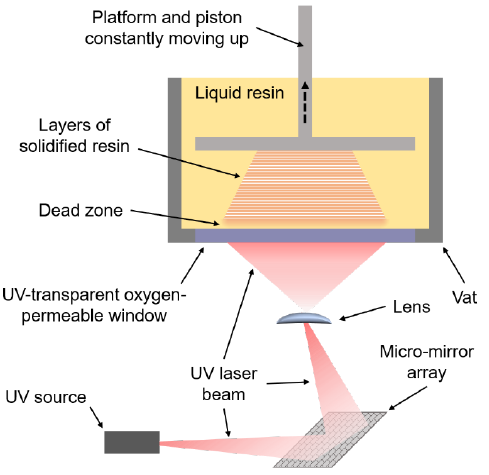
Figure 6. Schematic of a typical CLIP printing